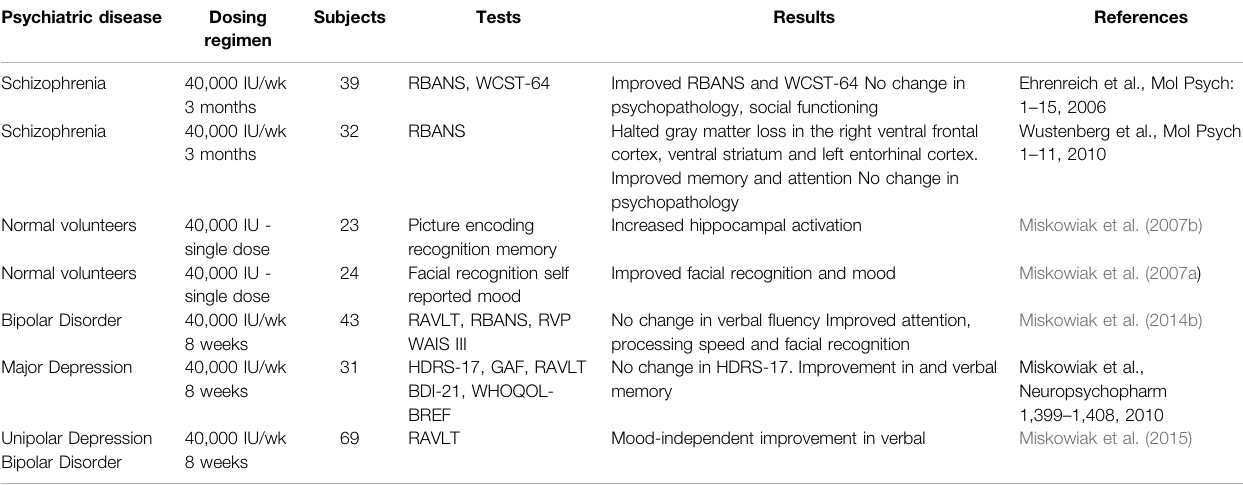
TABLE 1 | Clinical studies of the cognitive effects of EPO in psychiatric